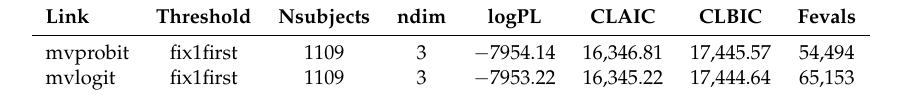
Table A6. Performance measures of the Multivariate Probit and Multivariate Logit specifications.